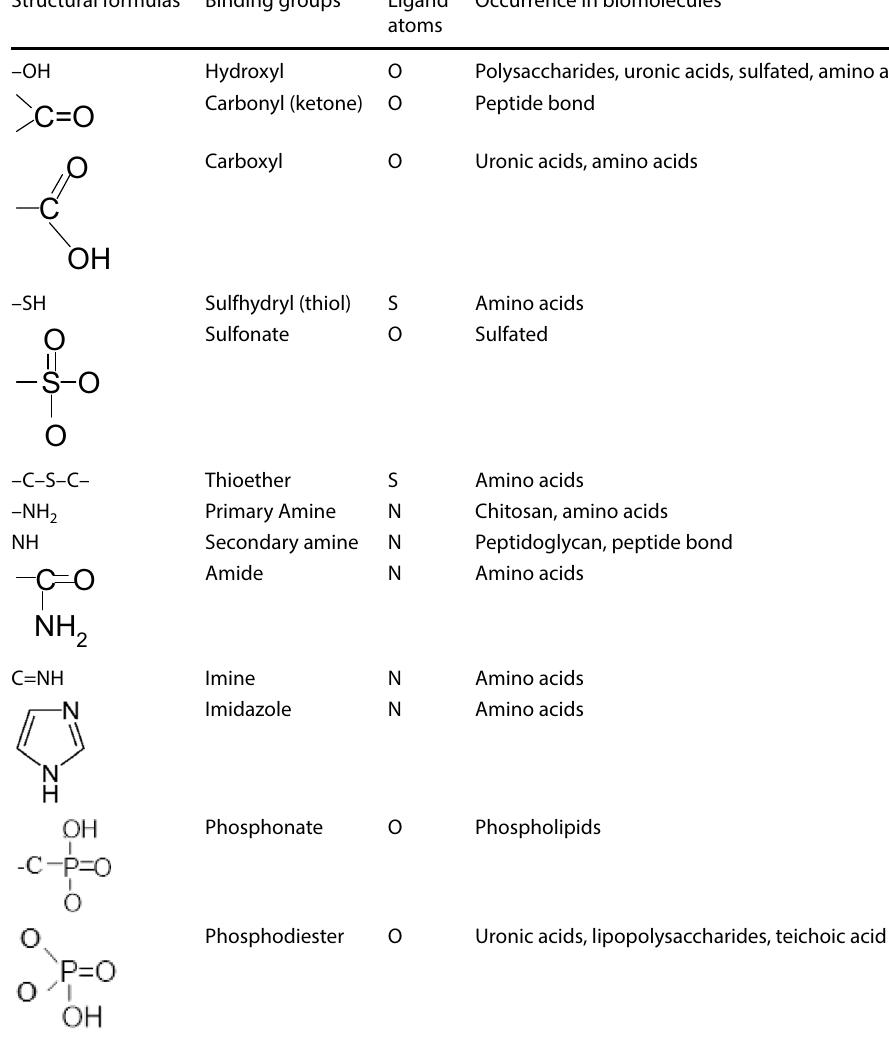
Table 4 Some of the main functional groups involved in biosorption. Source : adapted from [35]